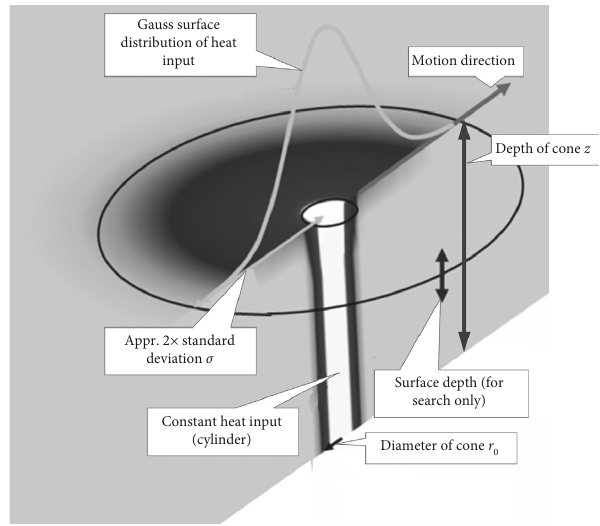
Figure 1: The compound heat source